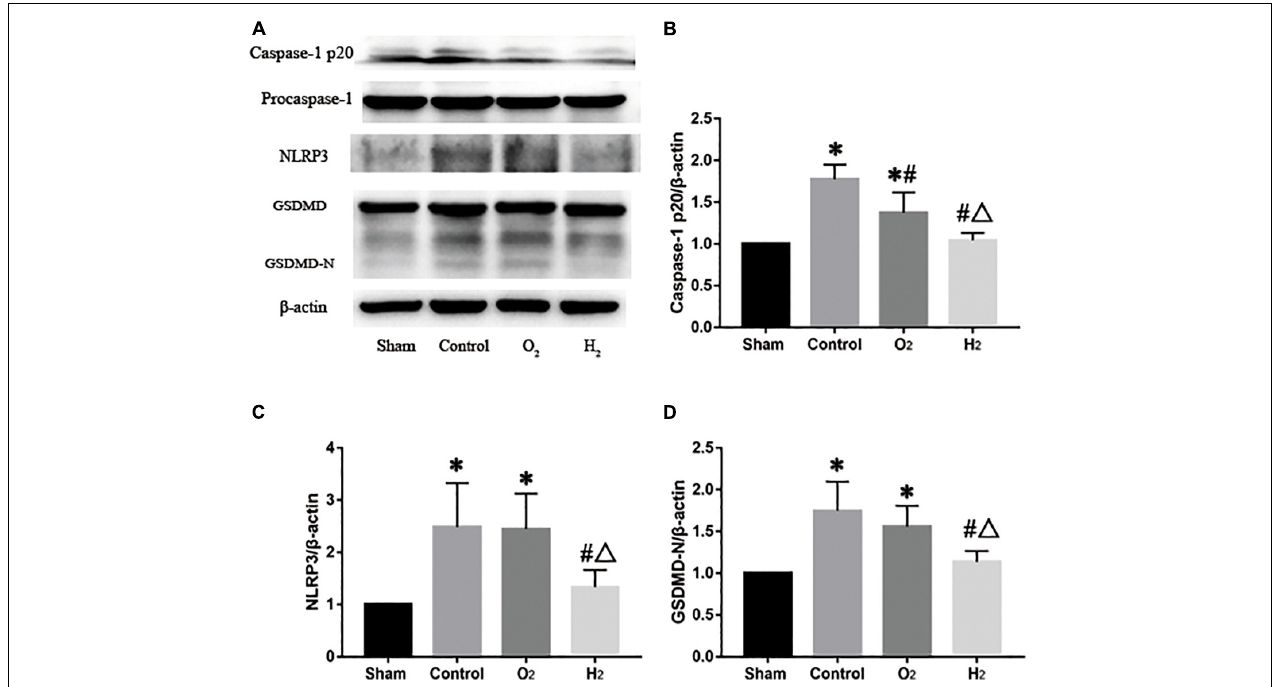
FIGURE 6 | The protein expressions in the lung graft ( n = 3). (A) Representative western blots and semiquantitative analysis of caspase-1 p20 (B) , NLRP3 (C) , GSDMD-N (D) . The expressions of caspase-1 p20, NLRP3, and GSDMD-N in the control group were higher than the sham group ( P < 0.05), Caspase-1 p20, NLRP3, and GSDMD-N in the O 2 group were lower than the control group, but the difference of NLRP3 and GSDMD-N had no statistically significant, Caspase-1 p20, NLRP3, and GSDMD-N in the H 2 group were lower than the control group and the O 2 group ( P < 0.05). ∗ P < 0.05 vs. sham group; # P < 0.05 vs. control group; (cid:77) P < 0.05 vs. O 2